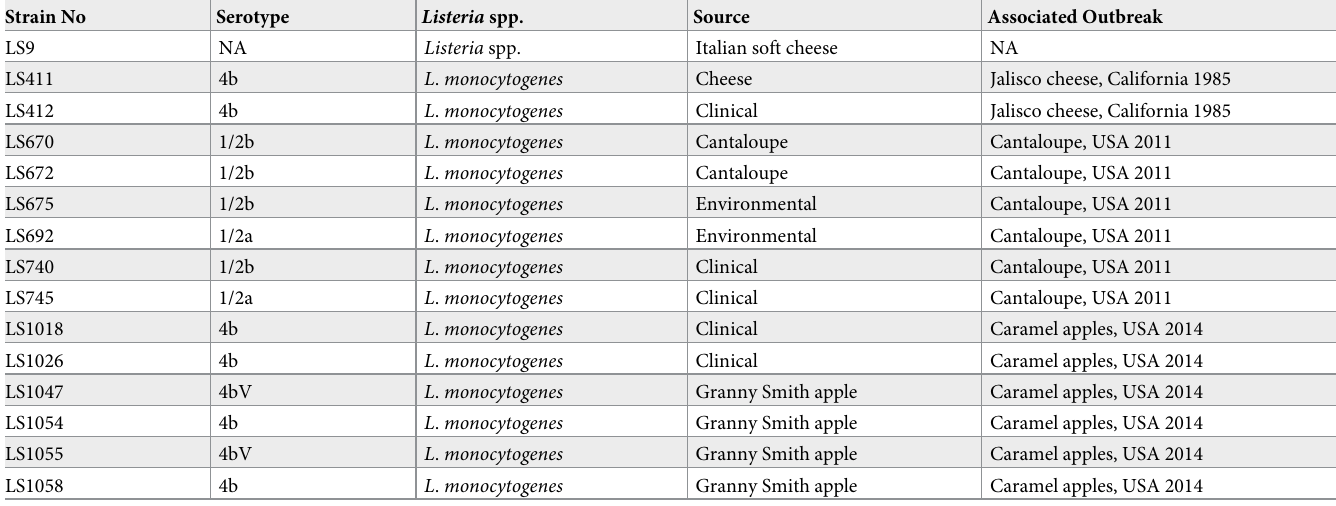
Table 1. Listeria strains employed in this study.